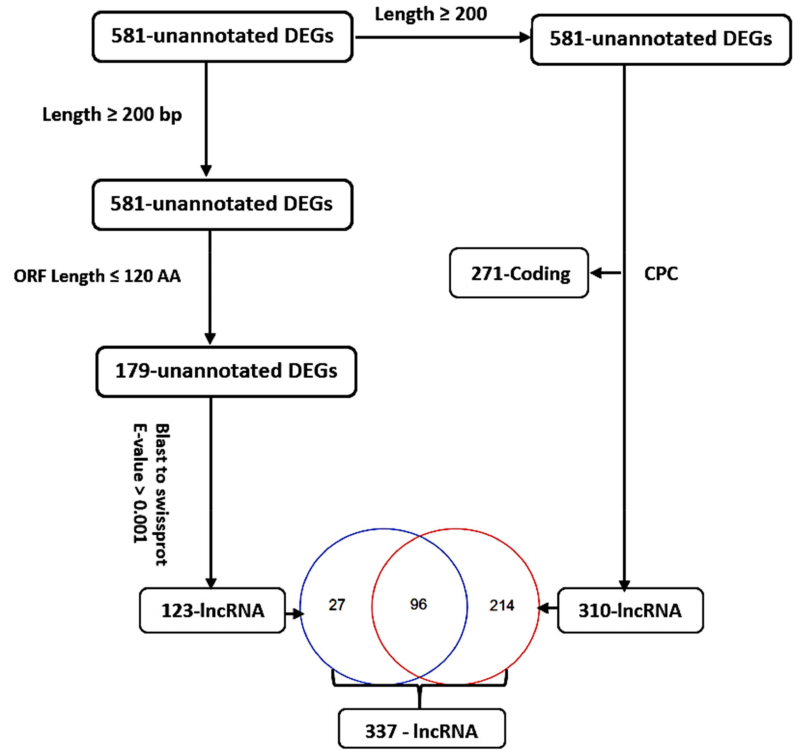
Figure 4. Analysis of 581 unannotated cold-responsive DEGs. CPC generated 271 coding and 310 long non-coding RNAs. The ORF method generated 123 long non-coding RNAs. In total, 337 putative long non-coding RNAs were generated by the two